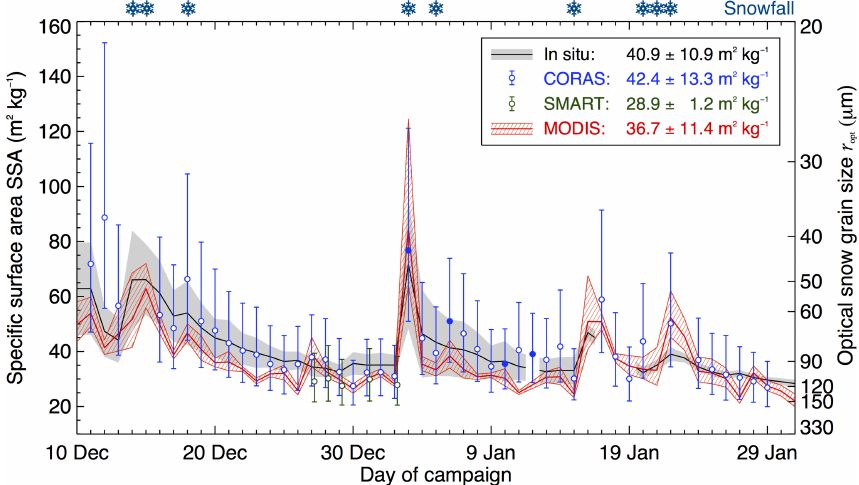
Figure 6. Time series of measured SSA and r opt for the entire campaign at Kohnen station. Black: mean (solid line) and standard deviation (shaded gray) for in situ measurements; red: MODIS retrieval; blue: CORAS retrieval in cloudless (open circles) and overcast (filled circles) conditions; green: SMART retrieval in cloudless (open circles) conditions. For better visibility, the SMART data points are slightly shifted to the right on the respective dates. Top right: mean and standard deviation of the SSA retrieved by the different instruments. Snowflake symbols denote snowfall